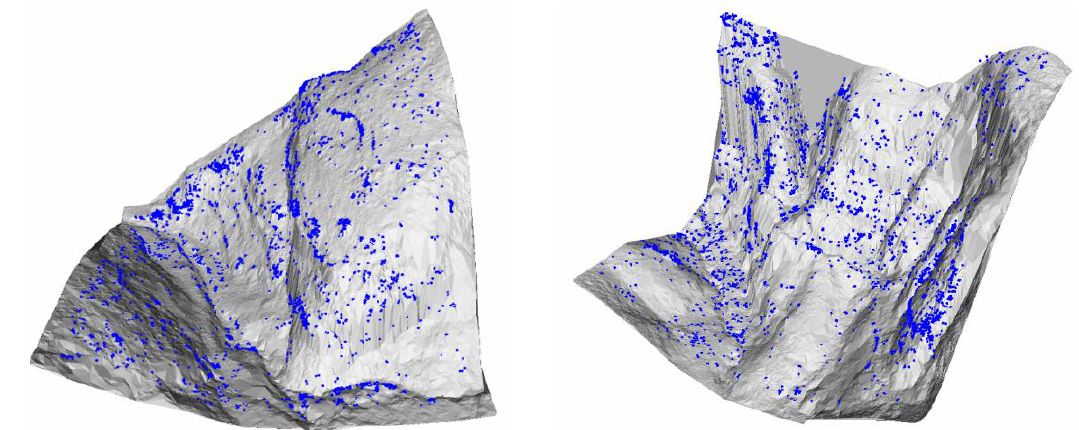
Figure 13. Extracted DEM of area 3 in dataset III. Blue denotes rejected ground points.